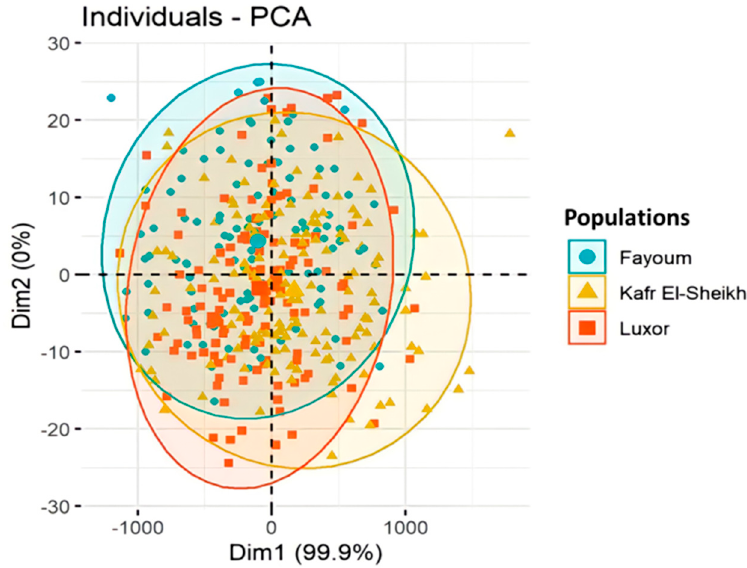
Figure 3. Plot of the principal components PC1 (Dim1) and PC2 (Dim2) and factor loadings from the principal component analysis (PCA) of body measurements in the three Egyptian goose popu- lations.